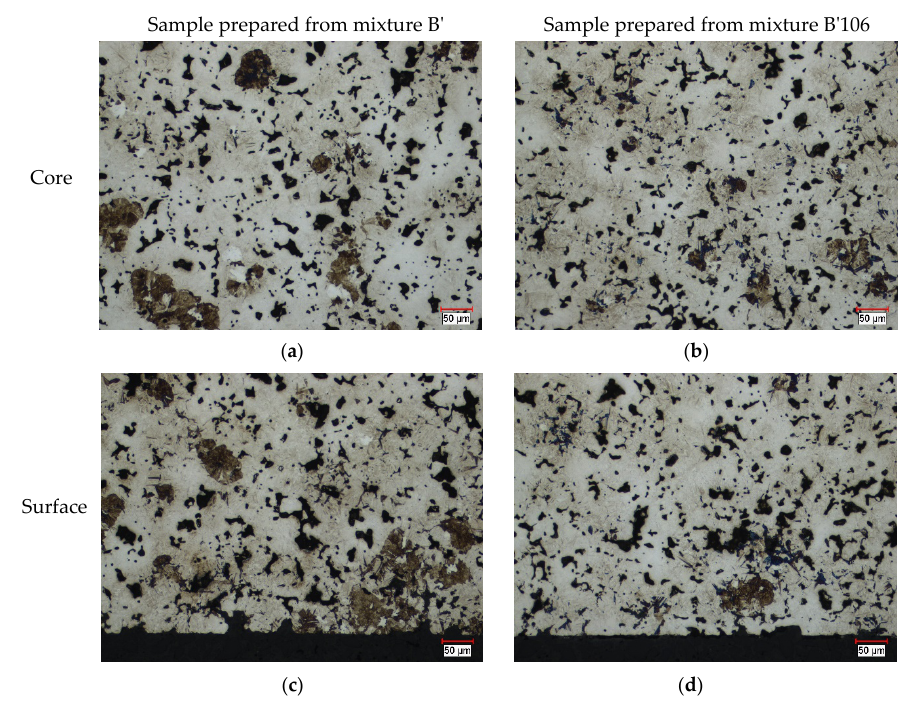
Figure 14. Optical images for sintered and heat treated bars prepared from powder mixtures B’ and B’106 using magnification 200×, images ( a ) and ( c ) are for a sample prepared from mixture B' at core and surface, images ( b ) and ( d ) are for a sample prepared from mixture B'106 at core and surface respectively.